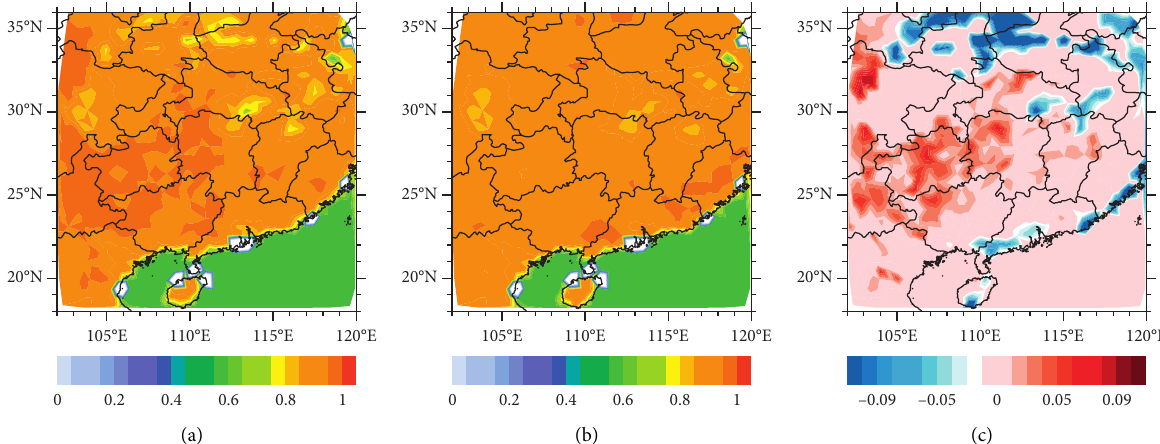
Figure 3: The emissivities from the clear sky (a), the TELSEM atlas (b), and the differences between the dynamic emissivity and the atlas (c) for MWHS-2/FY-3C after quality control at 0000 UTC 23 June 2016.